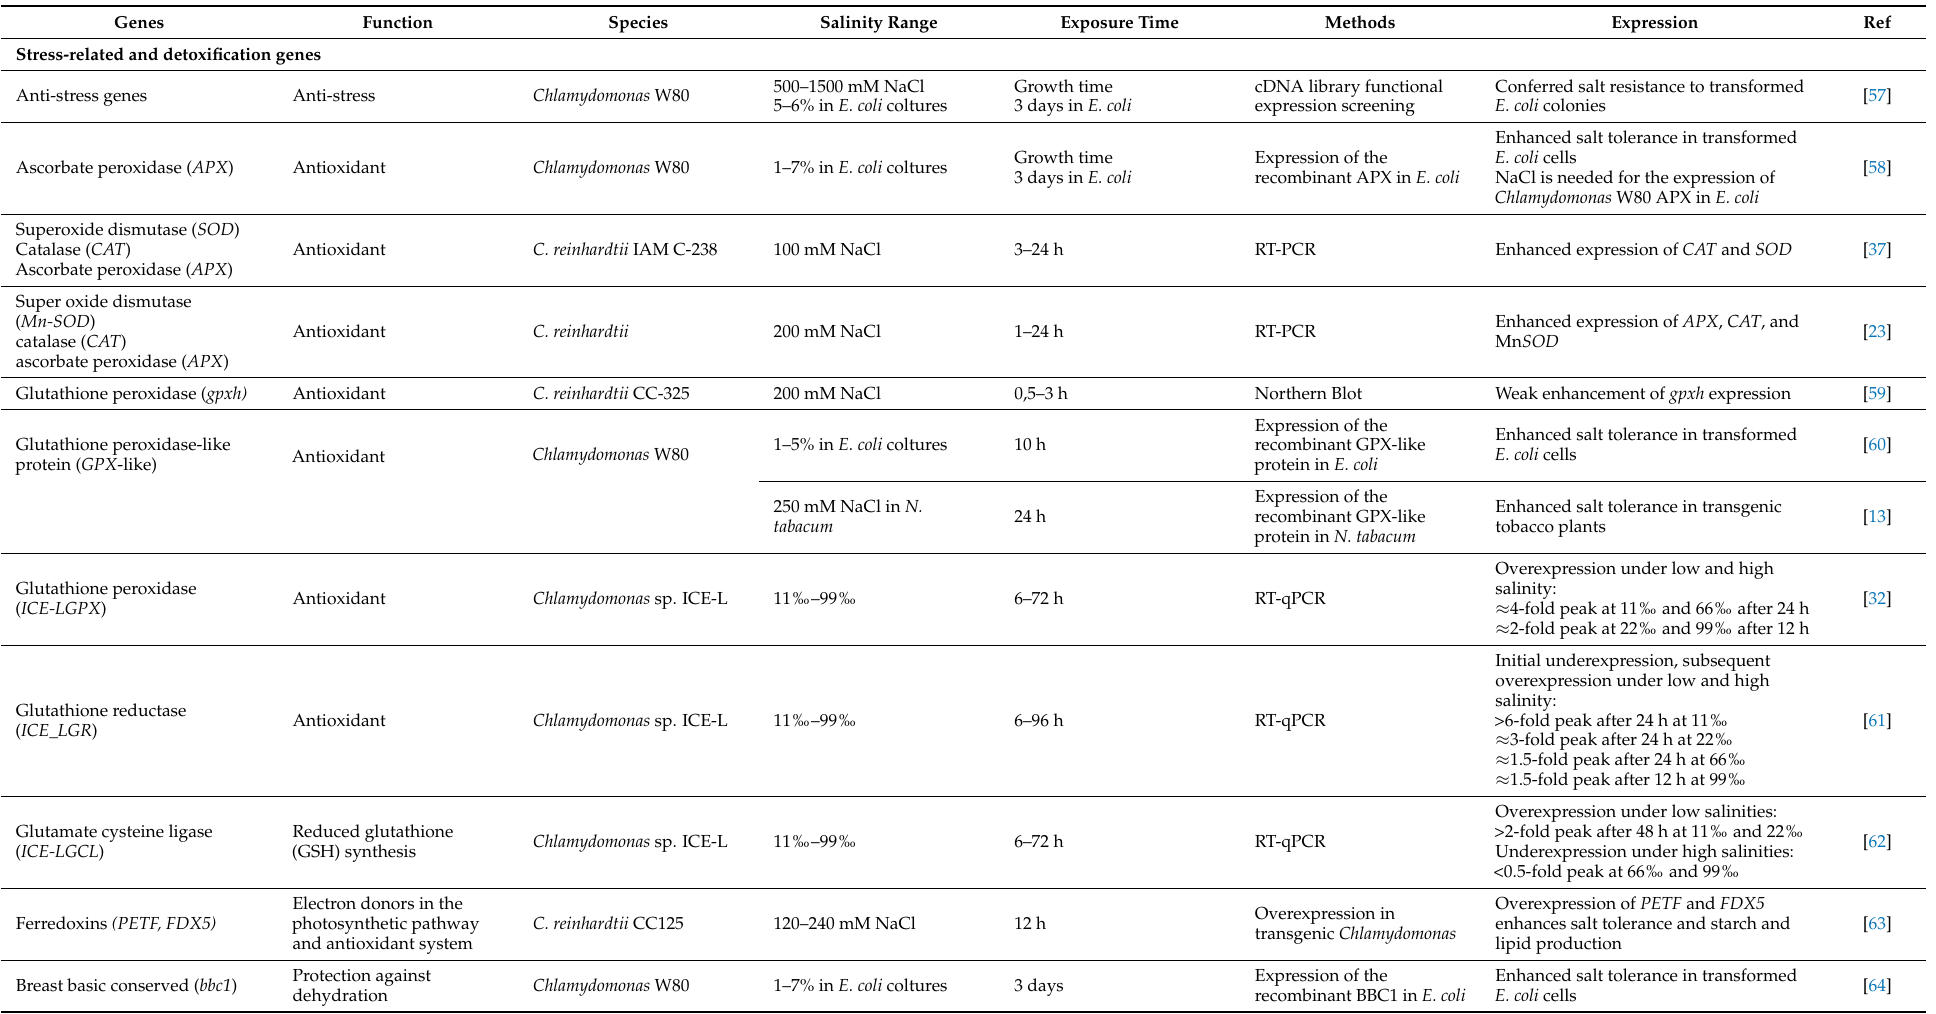
Table 2. This table summarizes main genes found to respond to various salinity ranges. RT-qPCR stands for reverse transcription-quantitative polymerase chain